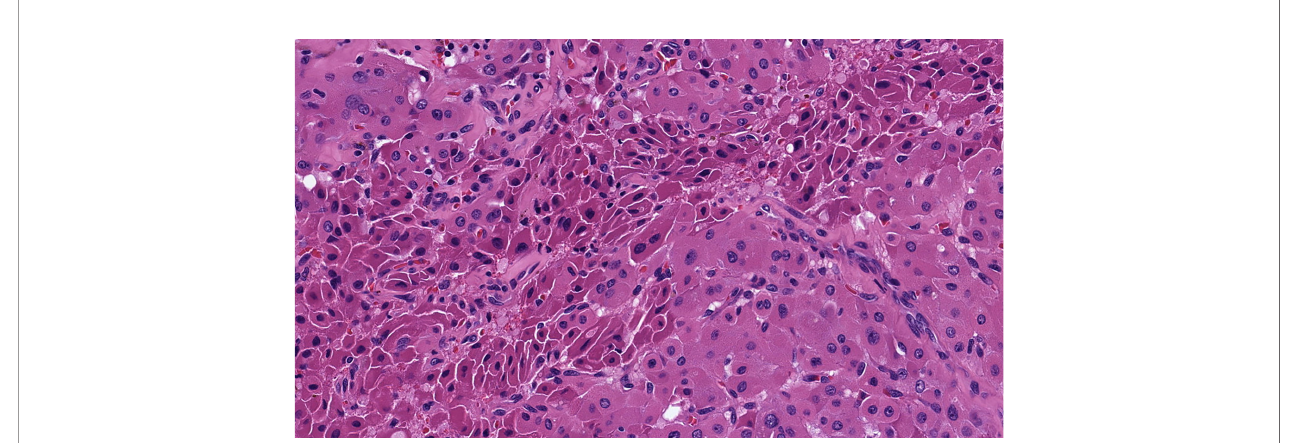
FIGURE 3 | Oncocytic poorly differentiated thyroid carcinoma. These tumors are oncocytic follicular cell-derived neoplasms that show solid/trabecular/insular growth in association with tumor necrosis and/or increased mitotic activity.